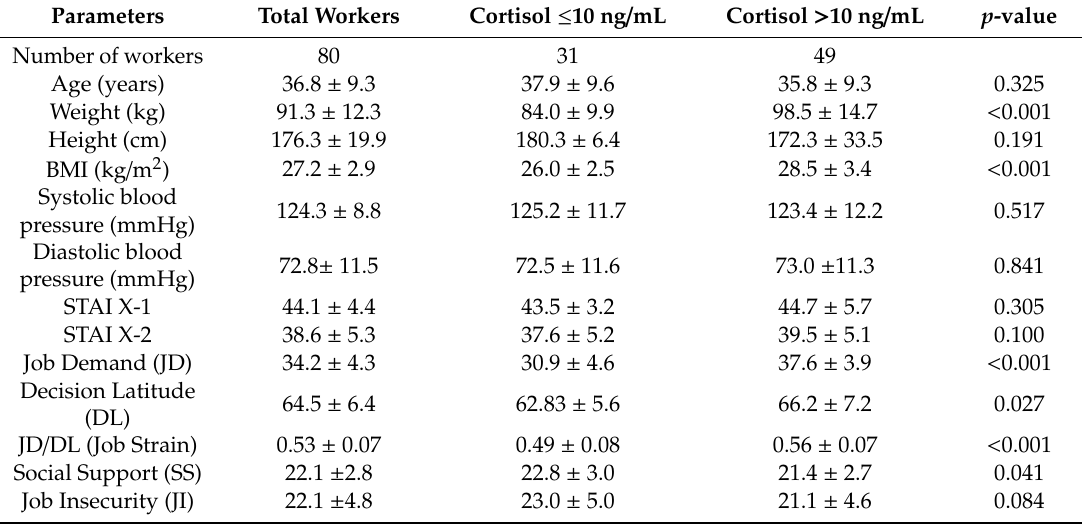
Table 1. Clinical-demographic details of overall workers and in workers with cortisol levels ≤ 10 or > 10 ng / mL.